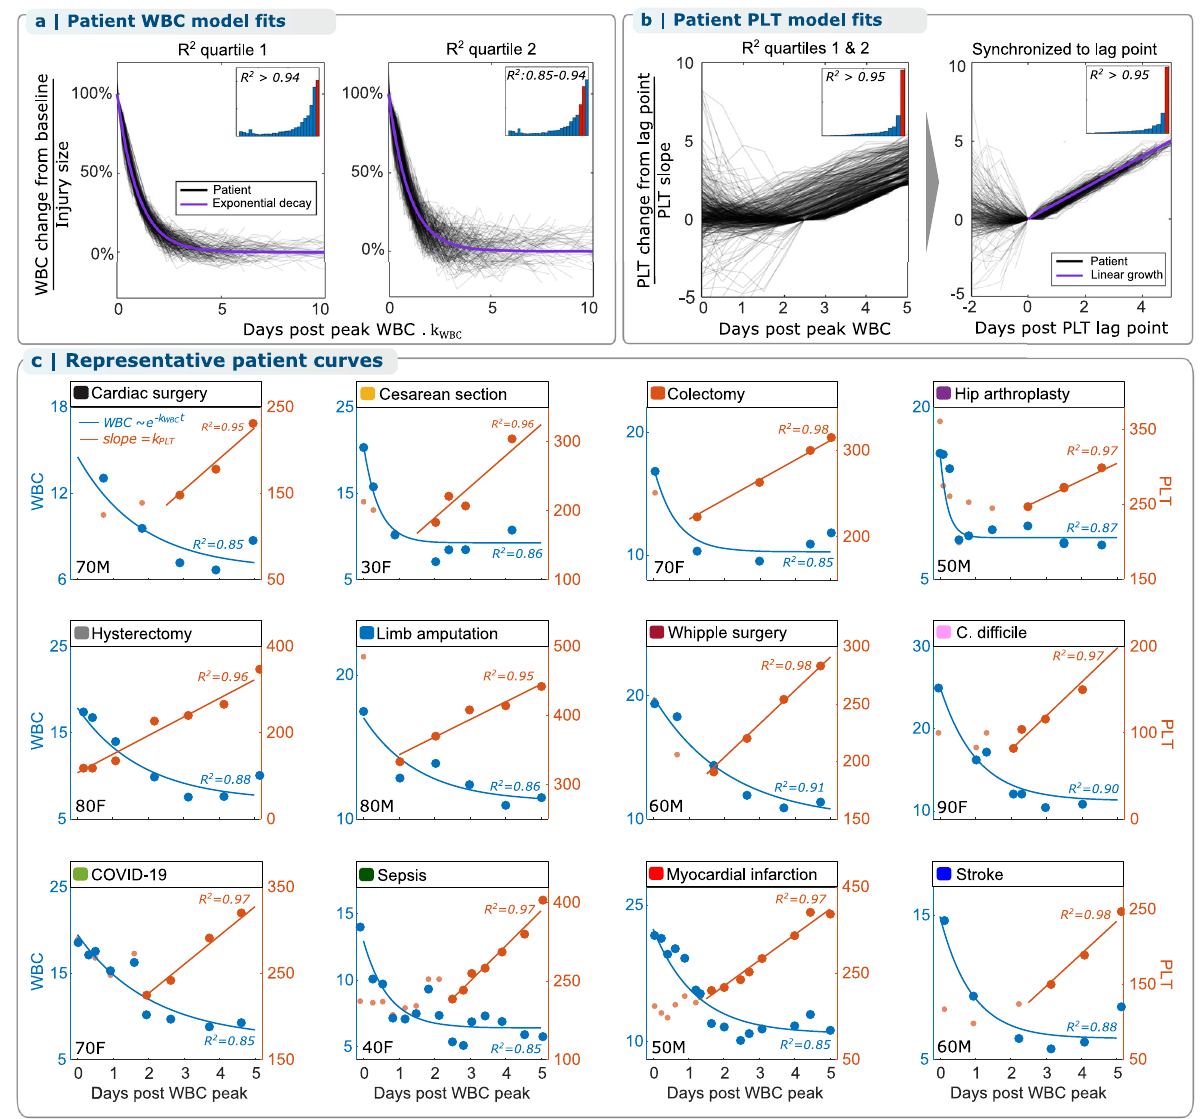
Fig. 3| Most individualrecoveringpatientsfollow thesameWBC-PLTrecovery shape,independentofin fl ammatorystimulus.a Acrossall12cohorts,individual patient WBC recovery dynamics are well-approximated by the model with median adjusted R 2 =0.85, as are individual PLT recovery dynamics ( b ) with a median adjusted R 2 of 0.95 following a variable delay. c WBC-PLT dynamics for repre- sentative patients follow the model. Representative patients are those with each in fl ammatory condition whose WBC-PLT data had model fi ts closest to the cohort median adjusted R 2 . These patients exhibit exponential WBC decay and delayed